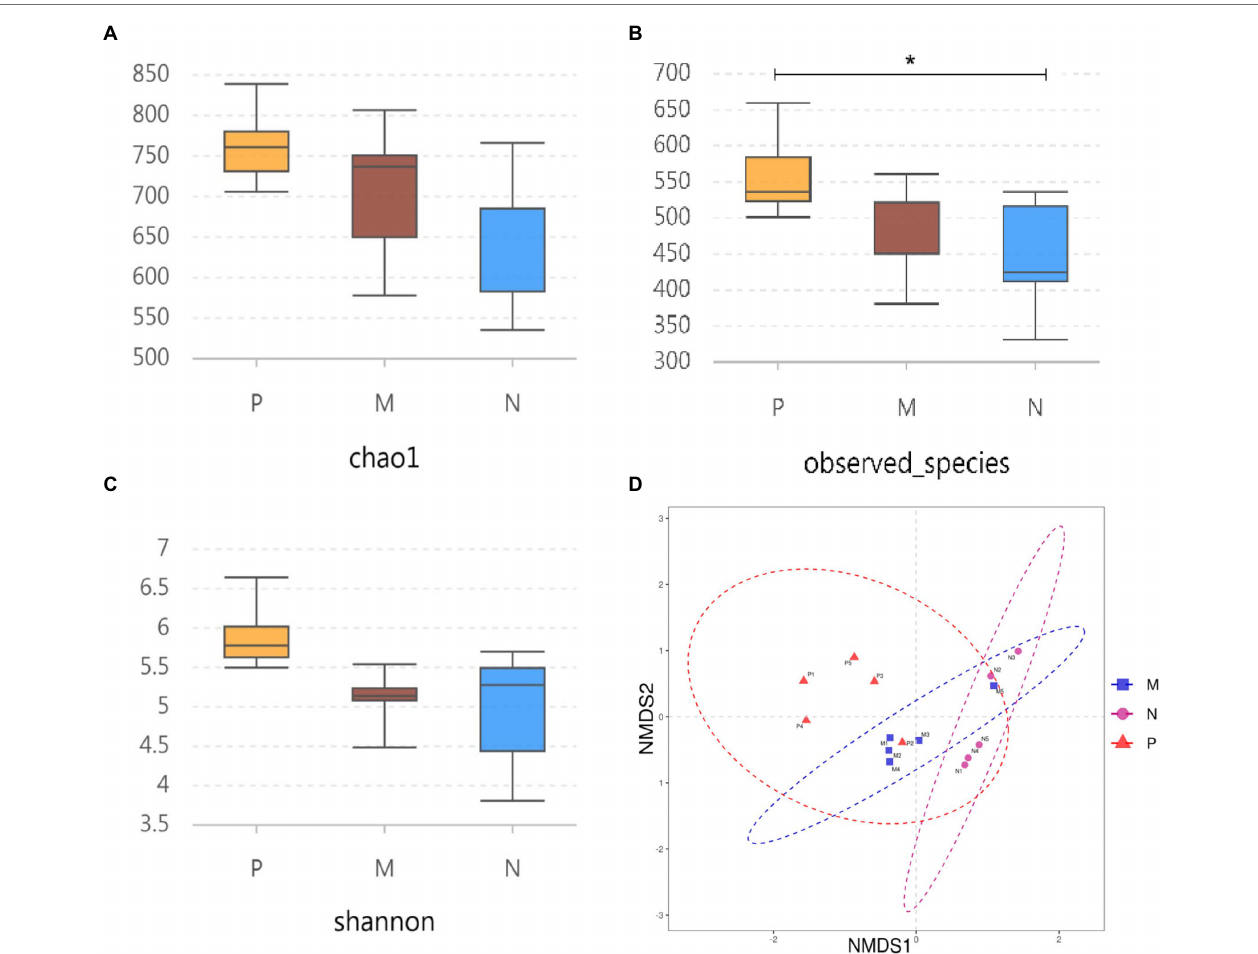
FIGURE 3 | α diversity analysis and β diversity of the three experimental groups were analyzed by sequencing the 16S rRNA gene. Chaol (A) and the observed number of species (B) were used as abundance estimates. The Shannon—Wiener index (C) was used as a diversity estimator. (D) NMDS was adopted to analyze the degree of difference between different samples to assess β diversity. The results were calculated for statistical significance using the t -test ( N = 5/ group). * P < 0.05. P, challenged H9N2 cells after pretreatment with PBS; M, challenged H9N2 cells after pretreatment with L. plantarum 0111. N, pretreatment with